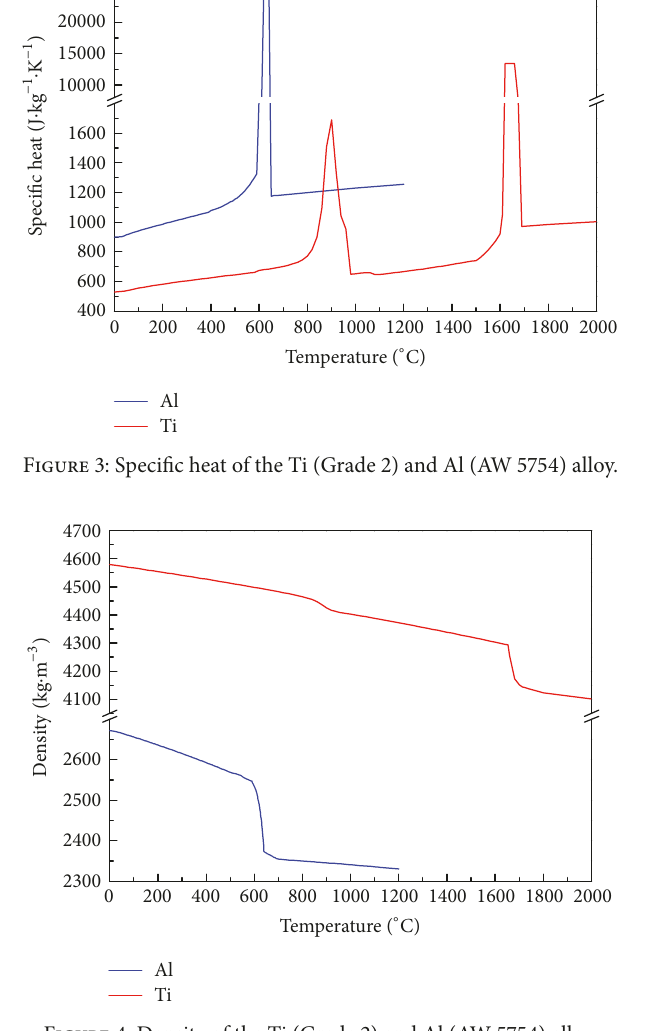
Figure 4: Density of the Ti (Grade 2) and Al (AW 5754)